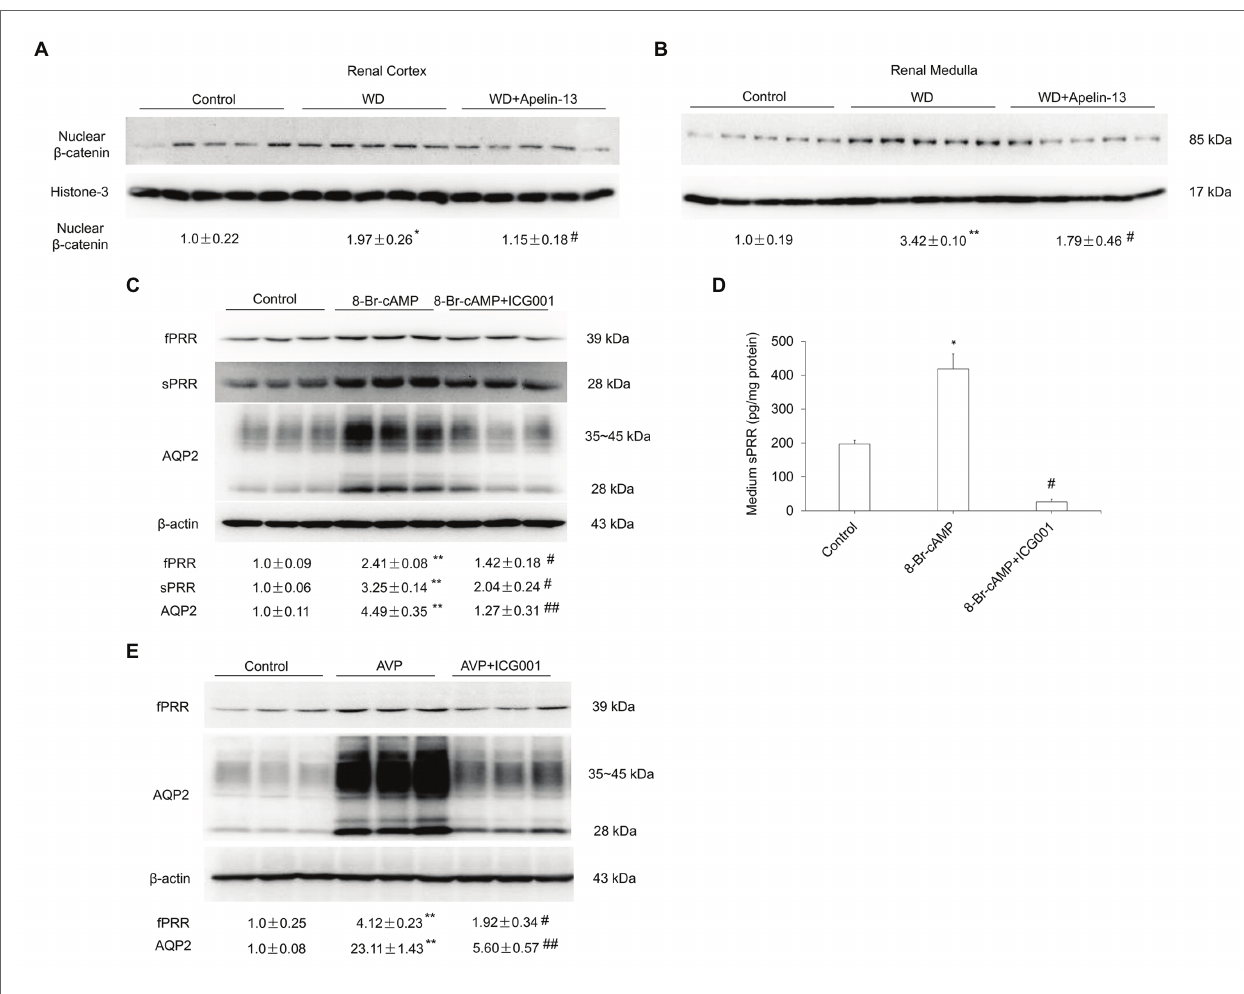
FIGURE 7 | Apelin regulates renal AQP2 expression via the cAMP/ β -catenin/sPRR signaling pathway. (A,B) Representative immunoblotting and densitometric analysis of nuclear β -catenin protein expression in the renal cortex (A) and medulla (B) in WD mice. The expression of AQP2 protein was analyzed by immunoblotting and normalized by Histone-3 as an internal control for equal loading of the samples. n = 5 per group. Data are mean ± SEM. * p < 0.05 and ** p < 0.01 vs. control; # p < 0.05 vs. WD. (C,D) Role of Wnt/ β -catenin signaling pathway in response to 8-Br-cAMP in primary rat IMCD cells. Cells were pretreated with ICG001 and then treated with 100 μ M 8-Br-cAMP for 24 h. (C) The expression of PRR and AQP2 protein was analyzed by immunoblotting and normalized by β -actin. (D) Medium sPRR levels were determined. n = 3 per group, repeated for three times. Data are mean ± SEM. * p < 0.05 and ** p < 0.01 vs. Control; # p < 0.05 and ## p < 0.01 vs. 8-Br-cAMP. (E) Role of Wnt/ β -catenin signaling pathway in response to AVP in primary rat IMCD cells. Cells were pretreated with ICG001 and then treated with 10 nM AVP for 24 h. The expression of PRR and AQP2 protein was analyzed by immunoblotting and normalized by β -actin. n = 3 per group, repeated for three times. Data are mean ± SEM. ** p < 0.01 vs. Control; # p < 0.05 and ## p < 0.01 vs.